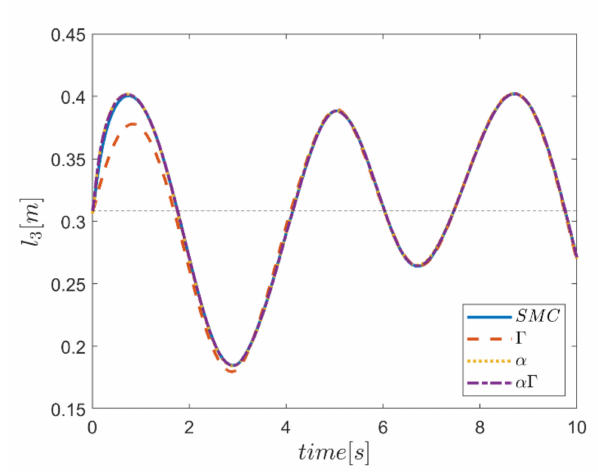
Figure 36. Comparison of the length of the third actuator.